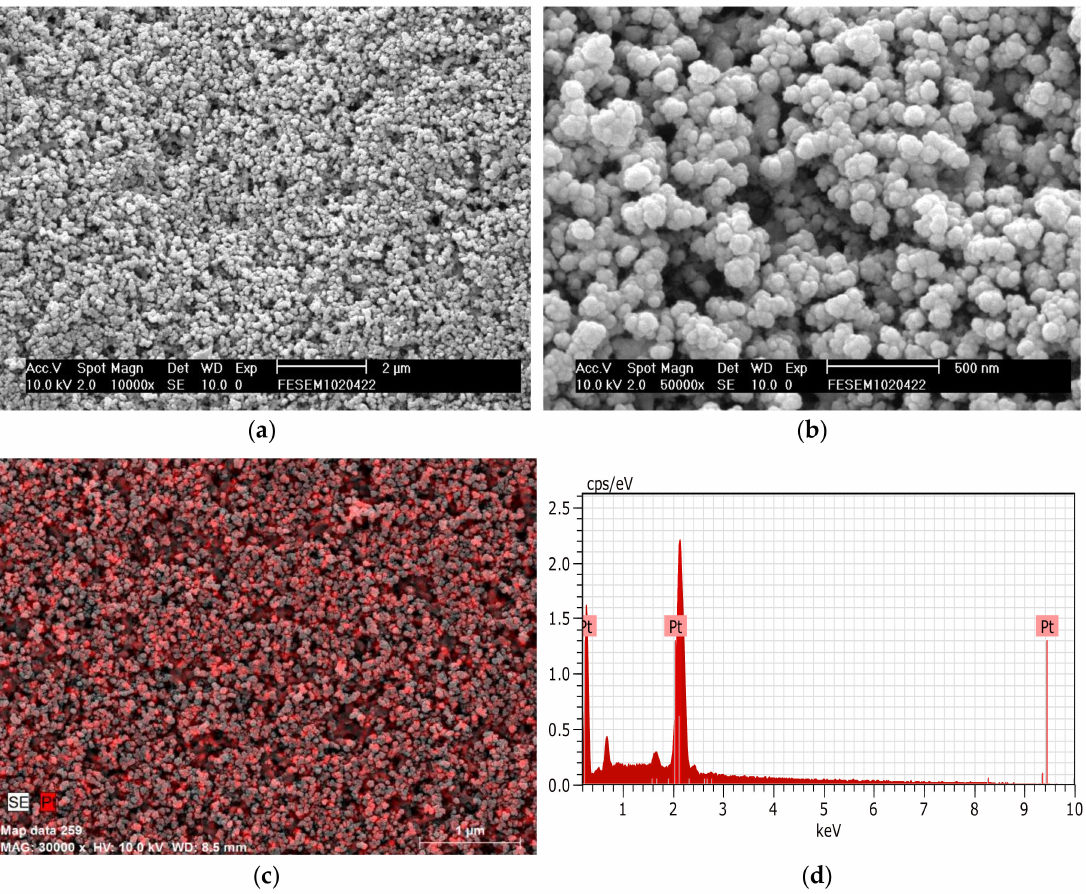
Figure 7. ( a ) SEM photograph ( × 10000), ( b ) SEM photograph ( × 50000), ( c ) EDX mapping image, and ( d ) EDX spectrum of supported Pt nanoparticles fabricated by SCD at 80 ◦ C and 6